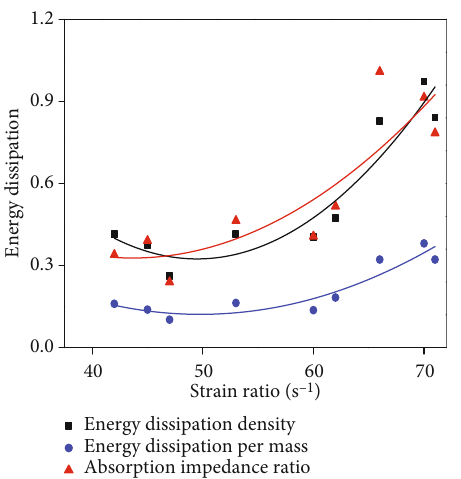
Figure 15: The relationship between energy indexes and average strain